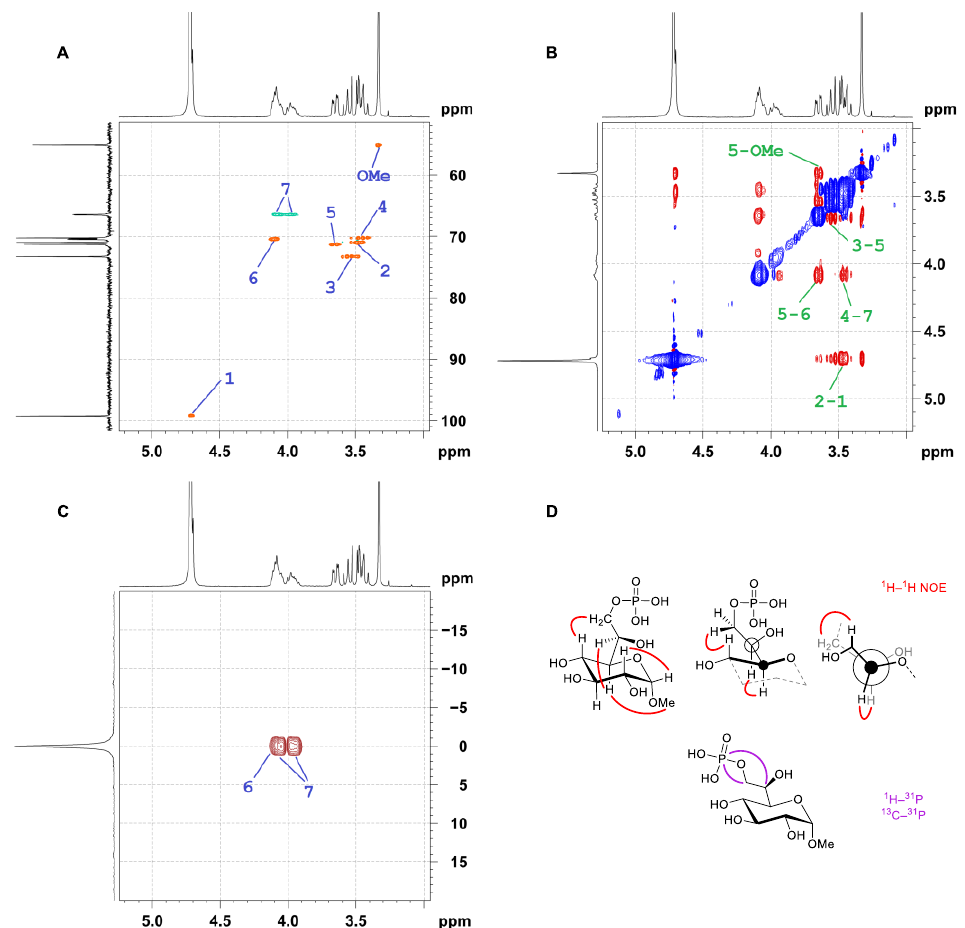
Figure 2. The representation of NMR spectra regions in D 2 O used for assignments: ( A ) 2D 1 H – 13 C edited-HSQC, ( B ) 1 H – 1 H NOESY and ( C ) 1 H – 31 P HMBC. ( D ) Accurate configuration assignment of